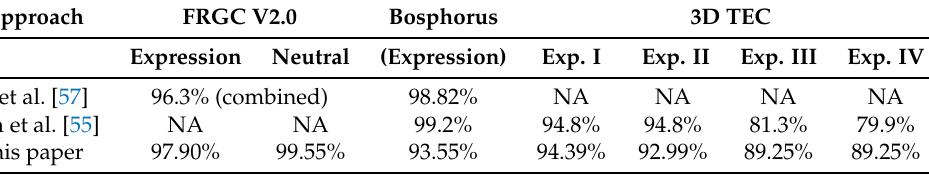
Table 1. Rank-1 identification rate comparisons on the three datasets.